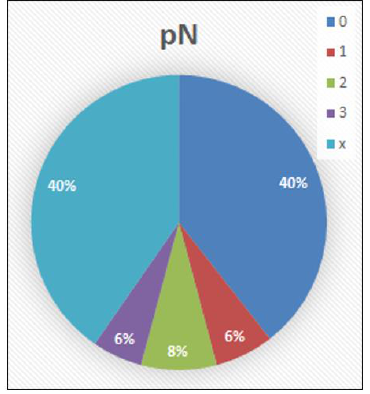
Figure 6. pN distribution.